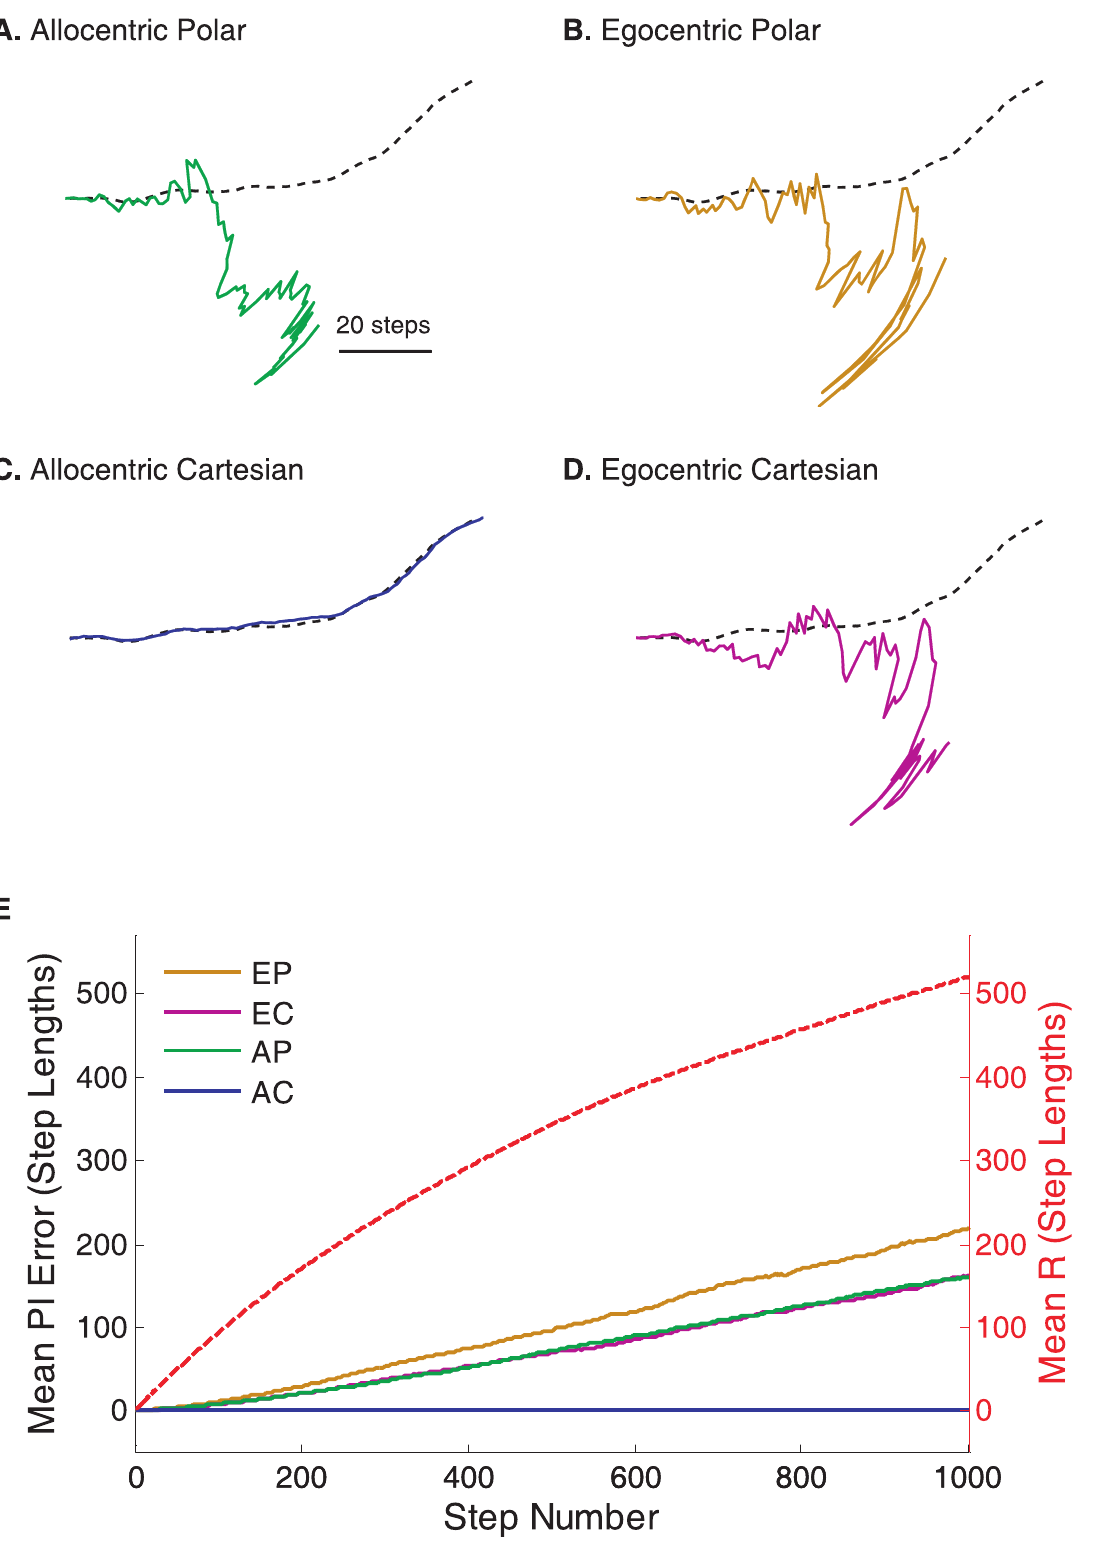
Figure 4. Quantifying the effect of noise during path integration (PI). An example is shown of noisy sensory inputs and home vector (HV) updating using allocentric polar (AP, A , green), egocentric polar (EP, B , gold), allocentric Cartesian (AC, C , blue), and egocentric Cartesian (EC, D , purple) coordinates. In each of the four examples, the actual path shown (dashed line) was an idiothetic directed walk (IDW) of 100 steps of step length 1 unit, generated assuming Gaussian random turns between successive steps, with a standard deviation of 0.1 radian. Gaussian noise with standard deviation of p /36 radians (5 u ) was added to compass readings and rotation measurements (denoted as d in text). Noise during updating of